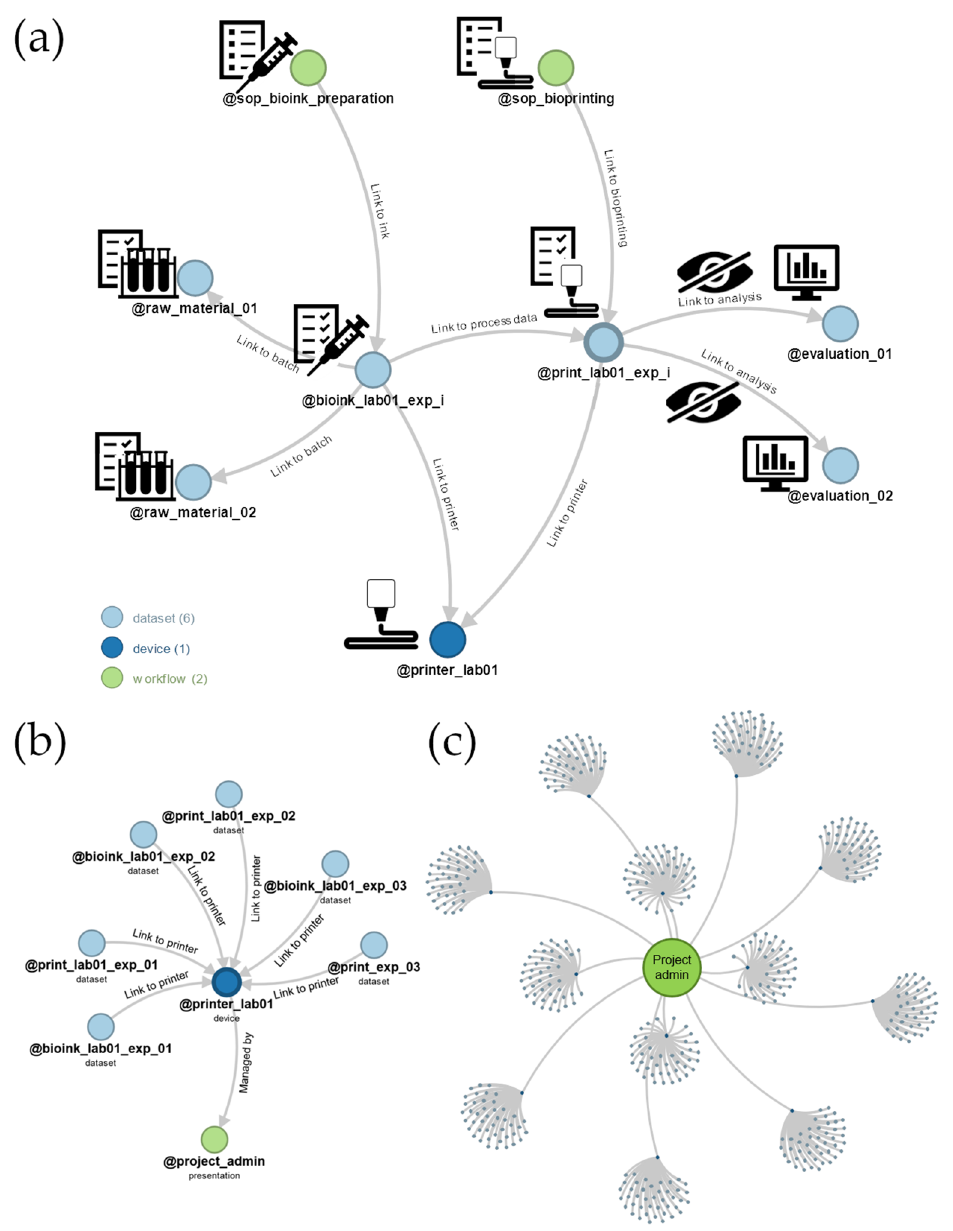
Figure 3. Visualisation of record links generated via Kadi4Mat, showing all outgoing and incoming links of the dataset record represented by the node in the centre (highlighted edges of node) up to a certain link depth. The linked records represent related datasets (light blue node), devices (dark blue) and workflows (green) in the form of SOPs. ( a ) An example dataset concerning bioprinting data of one run from pre- to post-processing and its linked records (link depth 3) of the process workflow: information contain the used devices (3D printer), the bioink batch and linked data as well as the used SOPs, each labelled with different icons. ( b ) All experiments executed with one printer within one lab are connected with a link depth of 1. ( c ) For the round robin test, only the project admin is able to access all hierarchically stored data from different labs (link depth 2 connecting project admin, printer and laboratory notebook entries of